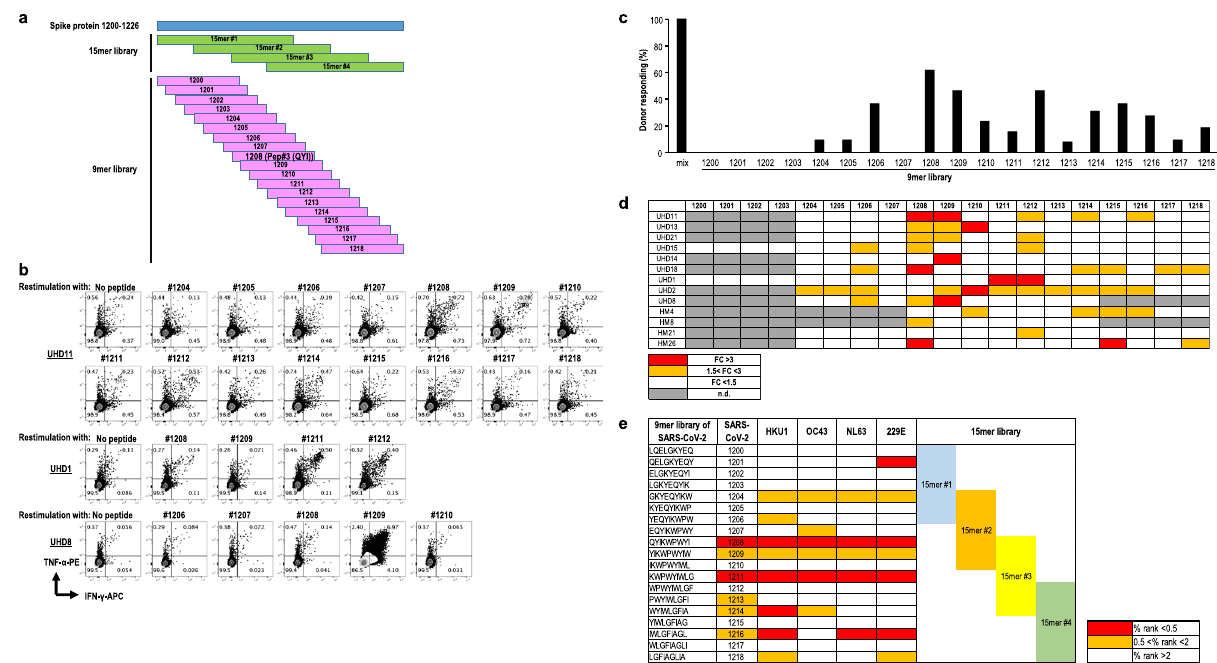
Fig. 4 Epitope mapping in spanning 15-mer peptide mix. a Design of 9-mer peptide library in S protein 1200 – 1226 . b Flow cytometry data from representative donors (UHD 1, 8, and 11) are shown. c Frequency of donors responding to each peptide of the 9-mer peptide library. d Response to 9-mer peptide-speci fi c CD8 + T cells selected from the 15-mer peptide mix. Data indicate that the fold change (FC) of CD8 + T (pep + ) to CD8 + T (pep − ) was 1.5 times higher (orange) and 3 times higher (red) in the 9-mer peptide, respectively. ( n = 12) Gray indicates not done. e In-silico analysis of the af fi nity for HLA-A24 in both SARS-CoV-2 S protein 1200 – 1226 and the relevant region of seasonal coronaviruses using IEBD and NetMHC4.0. (%rank < 0.5 (red), 0.5 < %rank < 2 (orange), %rank > 2